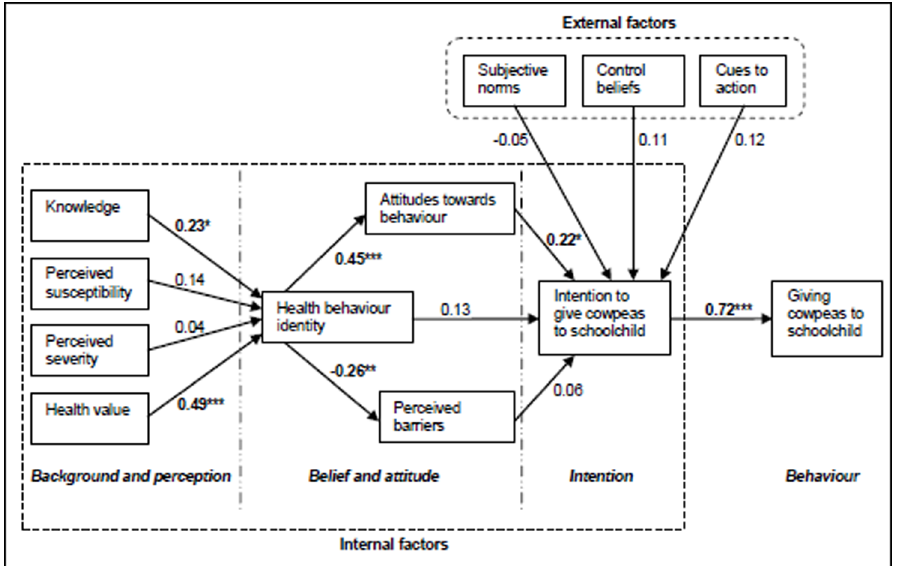
Figure 1. A combined model of the Theory of Planned Behaviour and Health Belief Model with correlation coefficients between related constructs. Adapted from Sun et al. [17]. * P , 0.05; ** P , 0.01; *** P , 0.001 (2-tailed).